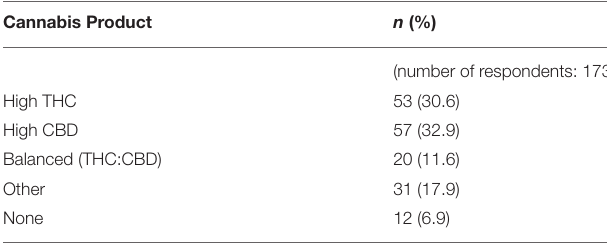
FIGURE 2 | Validated survey scores from the intake survey (baseline) and 6-week follow-up survey for patients reporting nociceptive and neuropathic pain types. Overall POQ-SF and the pain NRS scores showed improvements following 6 weeks of medical cannabis treatment. (A,B) . Nociceptive pain: (A) Overall POQ-SF score significantly decreased after 6 weeks of medical cannabis treatment ( t 56 = 5.116 P < 0.0001). (B) The pain NRS score significantly improved ( t 56 = 4.637 P < 0.0001) from 6.1 ± 1.7/10 at baseline to 4.9 ± 1.9/10 at the 6-week follow-up. ( C,D) . Neuropathic pain: (C) Overall POQ-SF score significantly decreased after 6 weeks of medical cannabis treatment ( t 39 = 2.261 P < 0.05). (D) The pain NRS score significantly improved ( t 39 = 2.994 P < 0.01) from 6.9 ± 1.5 /10 at baseline to 5.9 ± 2.1/10 at the 6-week follow-up, (**** P < 0.0001, ** P < 0.01, * P < 0.05). TABLE 3 | Information on preferred products for the medical cannabis patients who reported recurrent